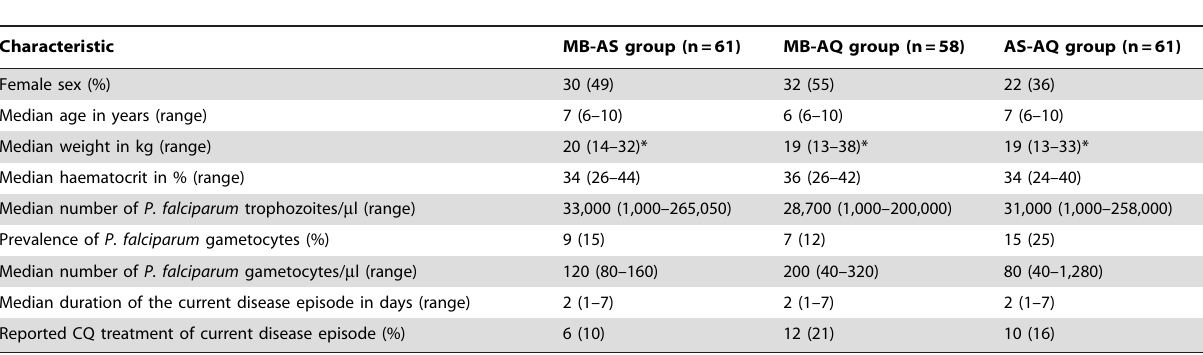
Table 1. Characteristics of study children at